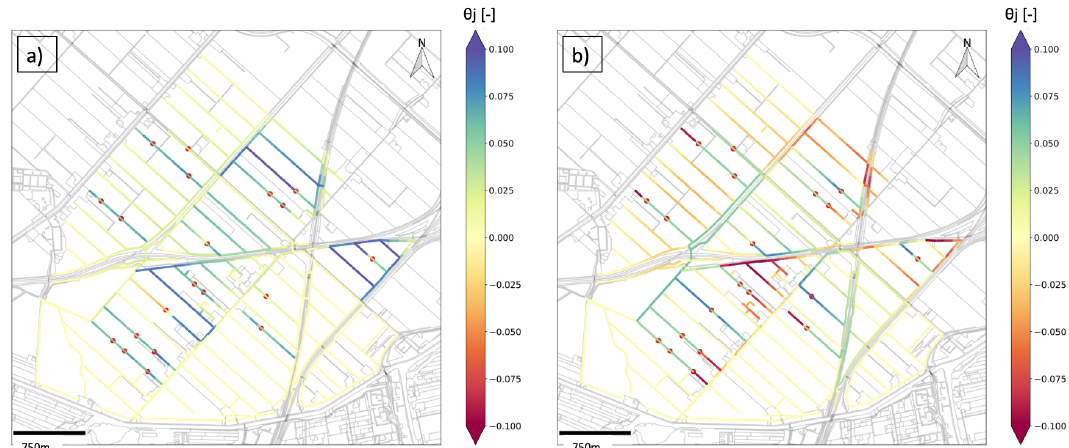
Figure 7. Principal component values, θ j , corresponding to each location for ( a ) first ( b ) second principal components. The boil locations are also shown with red dots in the ditches.